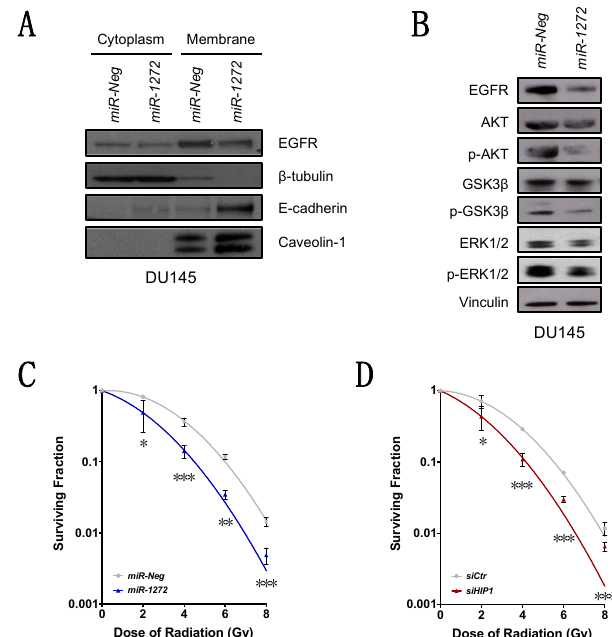
Figure 4. miR-1272 affects EGFR/AKT/ERK signaling and increases ionizing radiation response. ( A ) Representative immunoblotting showing protein levels of cytoplasmic and membrane-associated EGFR and E-cadherin in miR-Neg and miR-1272 transfected DU145 cells. β -tubulin and Caveolin-1 were used as controls for cytoplasm/membrane fractionation. ( B ) Representative immunoblotting showing protein levels of EGFR/AKT/GSK3 β /ERK pathway members in miR-Neg and miR-1272 transfected DU145 cells. Vinculin was used as endogenous control. ( C ) Clonogenic cell survival of DU145 cells transfected with miR-Neg or miR-1272 and exposed to increasing doses of irradiation (2, 4, 6 and 8 Gy). The surviving fraction is reported as mean ± SD values from 3 independent experiments. ( D ) Clonogenic cell survival of DU145 cells transfected with siCtr or siHIP1 and exposed to increasing doses of irradiation (2, 4, 6 and 8 Gy). The surviving fraction is reported as mean ± SD values from 3 independent experiments. * p < 0.05, ** p < 0.01, *** p < 0.001, Student’s t -test.